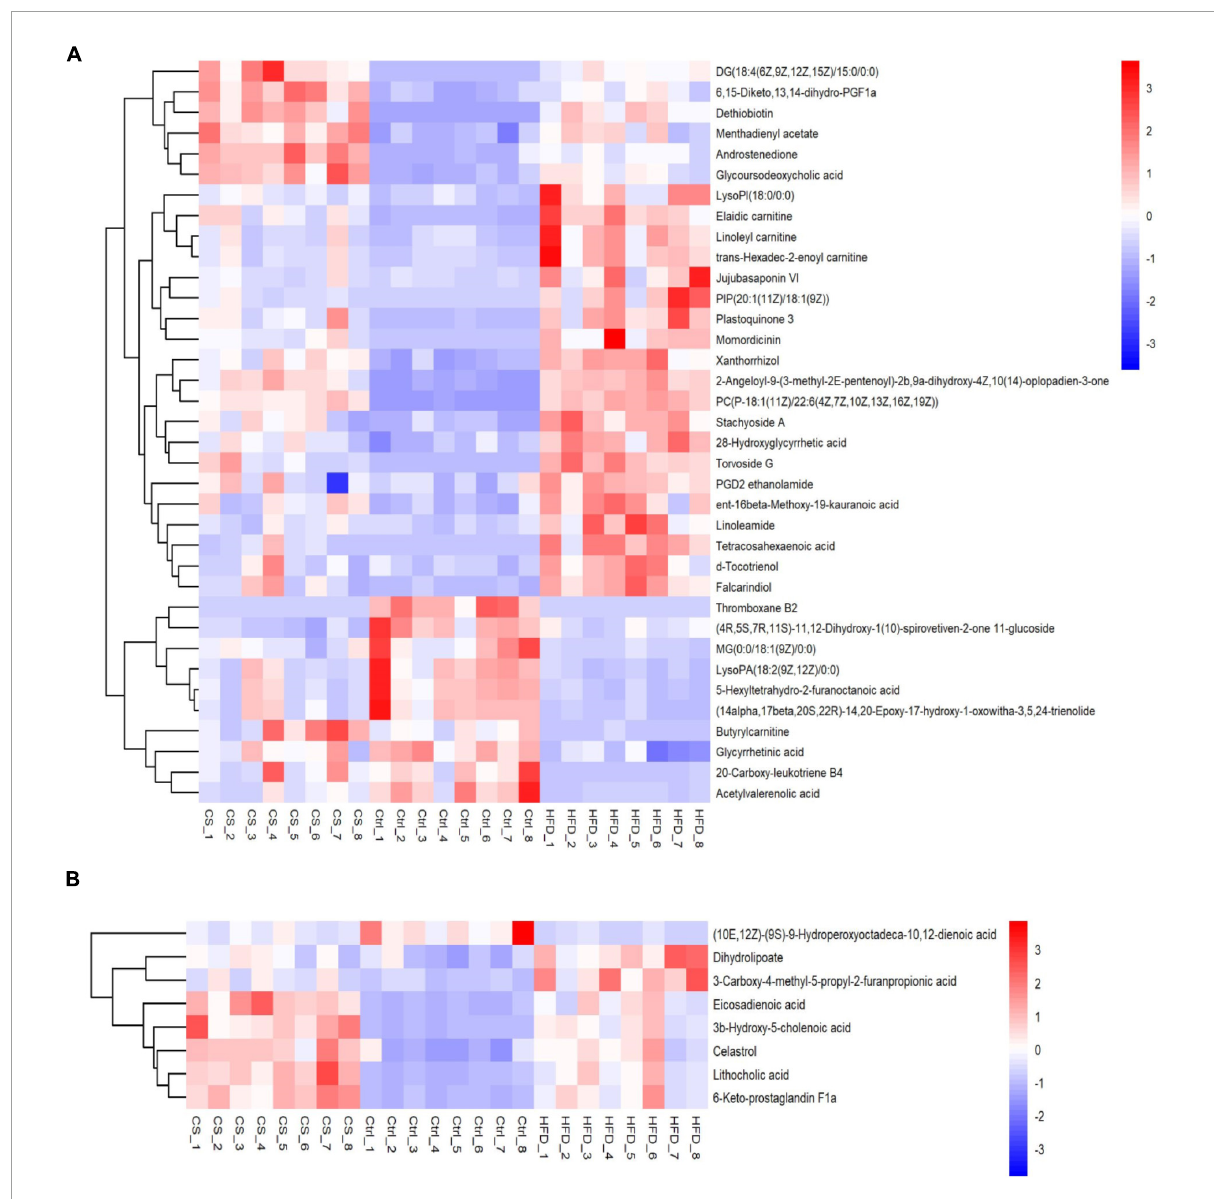
FIGURE9 Heatmap of lipids and lipid-like molecules shared by all groups ( A: POS ion, B: NEG ion). Control diet (Ctrl) group, high- fat diet (HFD) group, corn silk (CS) group.